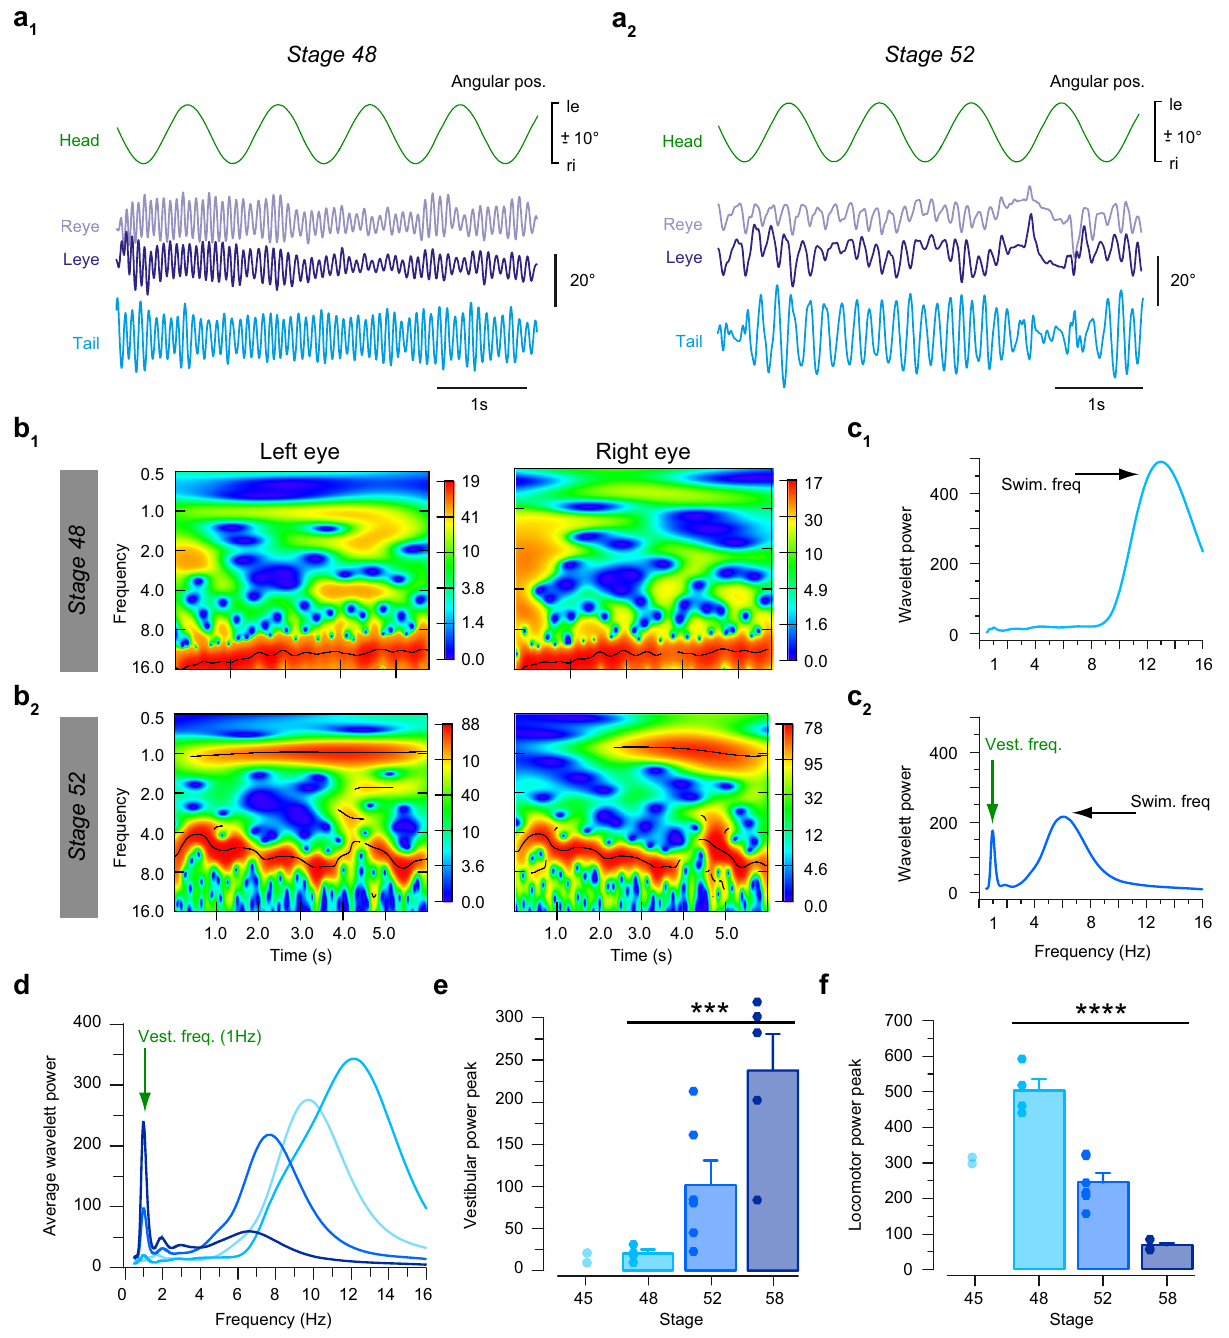
Fig. 4 Stage-speci fi c integration of semicircular canal and spino-ocular motor signals during locomotion. Representative recordings ( a ) and spectrograms ( b ) depicting the power spectrum of movement frequencies of the left (Leye) and right eye (Reye) at stage 48 ( a 1 , b 1 ) and stage 52 ( a 2 , b 2 ) during swim-related tail undulations (blue trace in a 1,2 ) and concurrent horizontal head rotation at 1Hz with positional excursions of ± 10° (green traces in a 1,2 ); the occurrence of each frequency within the eye motion pro fi le from 0.5 – 16Hz is indicated by the color gradient from blue (rare) to red (often); black lines refer to signi fi cantly different wavelet power values within the spectrum. Color scales, blue to red, at the side of each spectrogram represents the amplitude of wavelet components, low to high respectively, relative to the occurrence of each frequency. c Periodograms of two representative recordings at stage 48 ( c 1 ) and stage 52 ( c 2 ); note that eye movements at stage 48 consist of a single principal frequency that coincides with the tail undulations (Swim. freq. ~13Hz), while those at stage 52 contain two clearly discernible frequencies representing tail undulations (Swim. freq. ~6Hz) and horizontal head rotation (Vest. freq. 1Hz). Average periodogram of eye movements ( d ) during combined swim-related tail undulations and head rotations at 1Hz at selected stages (color-coded); note the developmental changes of the frequency component related to the vestibular stimulus at 1Hz ( e ) and the swimming frequency ( f ), summarized in the histograms (mean values±SEM) of average wavelet power amplitudes ( e , f ) at stage 48 ( N = 4), 52 ( N = 6) and 58 ( N = 5); statistical signi fi cance using the Kruskal-Wallis test was performed between these stages. Exact p values calculated were equal to 0.001 for histogram ( e ) and less than 0.0001 for histogram ( f ). Note that values of stage 45 ( N = 2) were not used in descriptive statistics and statistical test due to the small animal number. Statistical signi fi cance is indicated as **** p <0.0001 and *** p <0.001 in ( e , f ); le, ri, leftward, rightward movement. Source data are provided as a Source Data fi